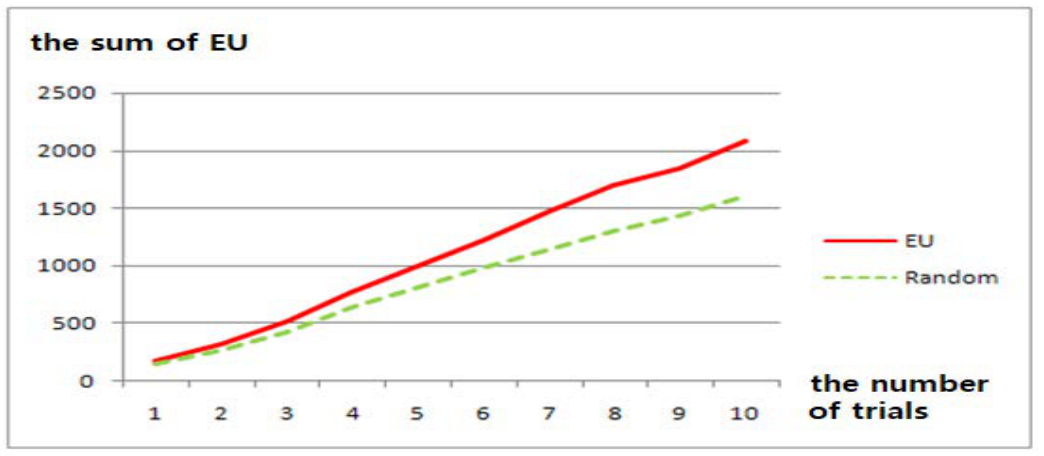
Figure 5. Total sum of expected utilities in scenarios using four robots and four